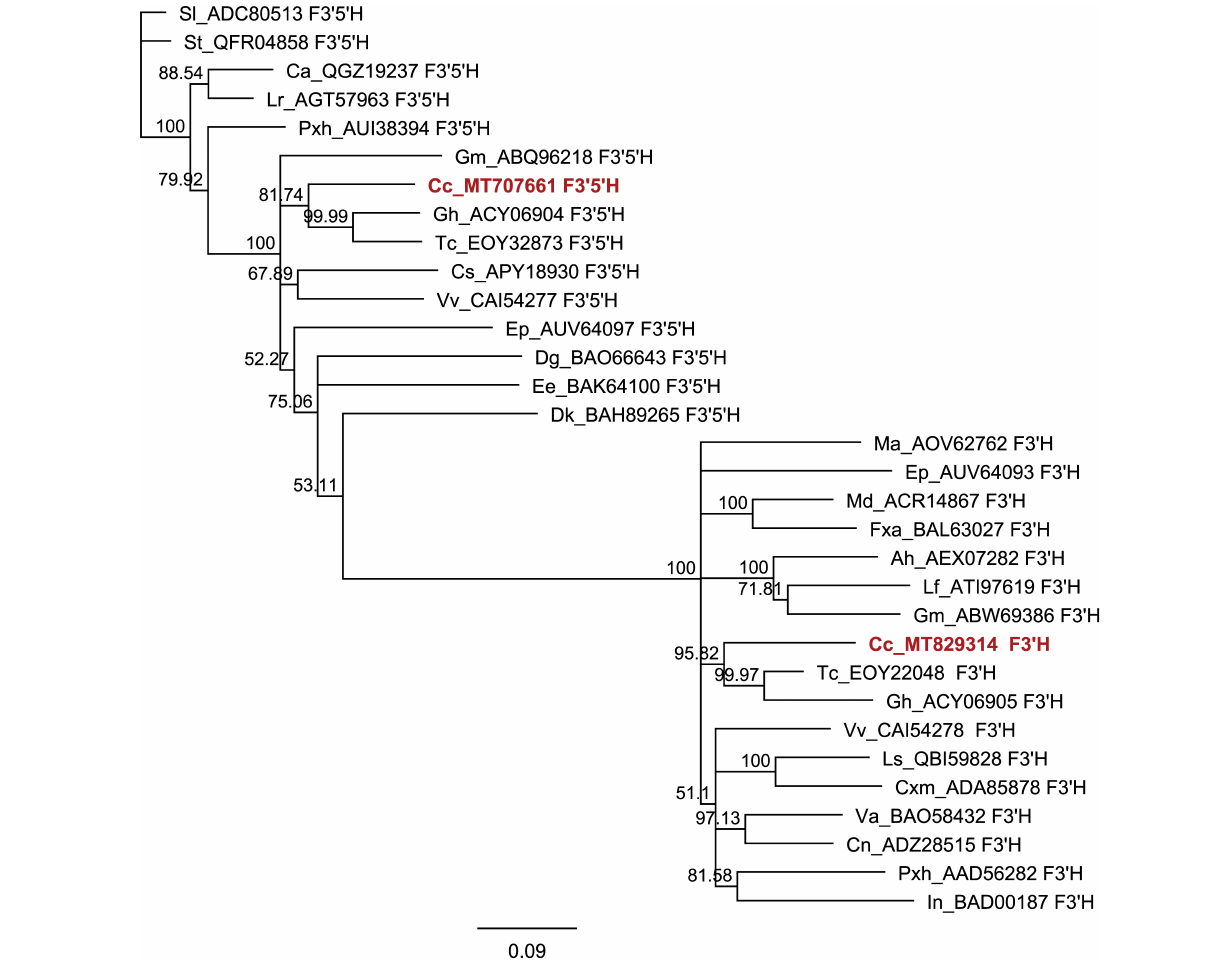
FIGURE 8 | Protein sequences for F3 (cid:48) H and F3 (cid:48) 5 (cid:48) H in various plant species available in GenBank were selected, including those of Cistus creticus . Sequences were aligned using ClustalW and phylogenetic distance tree analysis followed in Geneious Tree Builder, with Jukes–Cantor genetic distance model and neighbor-joining method. A consensus tree was built using bootstrap resampling tree method, with 10,000 replicates and majority greedy clustering. The scale bar indicates 0.09 amino acid substitutions per site. Bootstrap values are shown in nodes. The accession numbers displayed are given in Supplementary Table 3